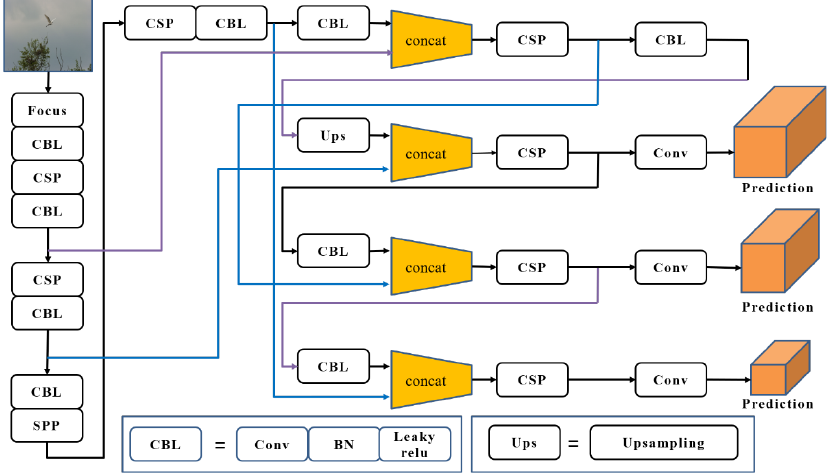
Figure 4. Optimized YOLOV5 detector structure.